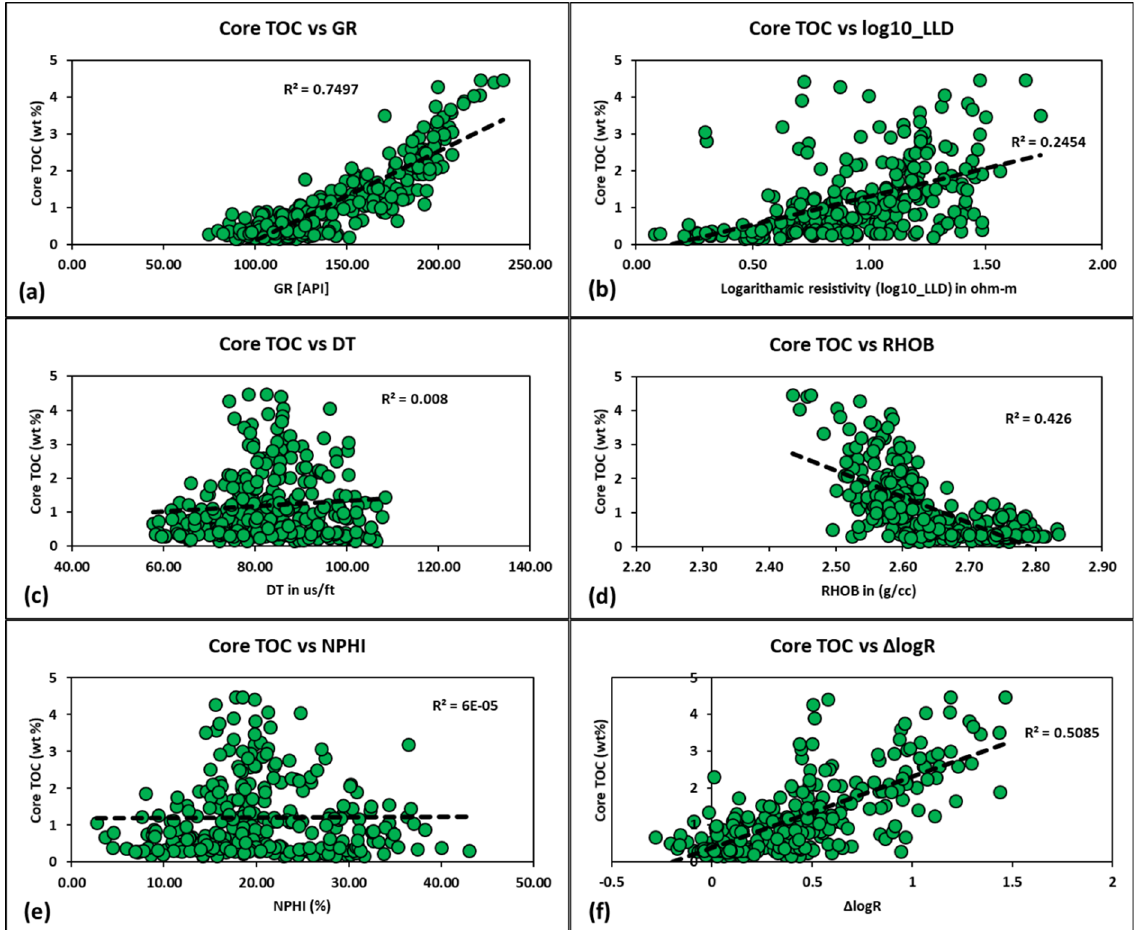
Figure 13. Cross ‐ plot of input features (petrophysical logs) and core TOC: ( a ) gamma ‐ ray (GR), ( b ) logarithmic of deep resistivity (log10_LLD), ( c ) compressional sonic travel time (DT), ( d ) bulk density (RHOB), ( e ) neutron porosity (NPHI), and ( f ) separation of sonic and resistivity log ( Δ logR).